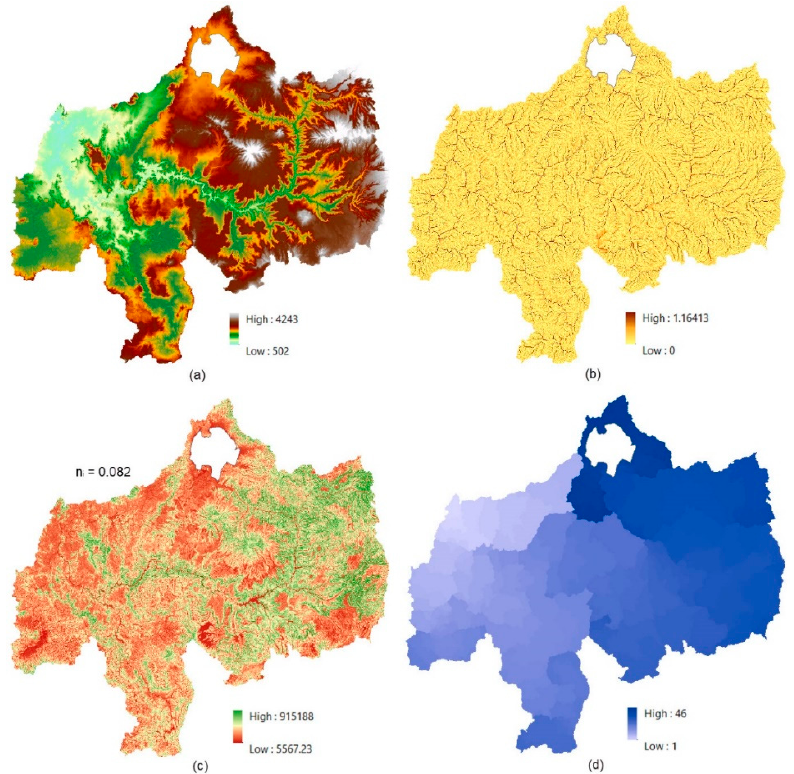
Figure 4. GIS grid-based calculations of arrival time grid of surface water. ( a ) DEM (m); ( b ) RGrid (m); ( c ) VsGrid (m/d); ( d ) TsGrid (d).